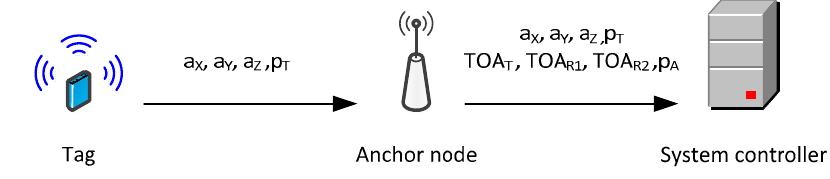
Figure 6. Measurement results transmitted in the system.